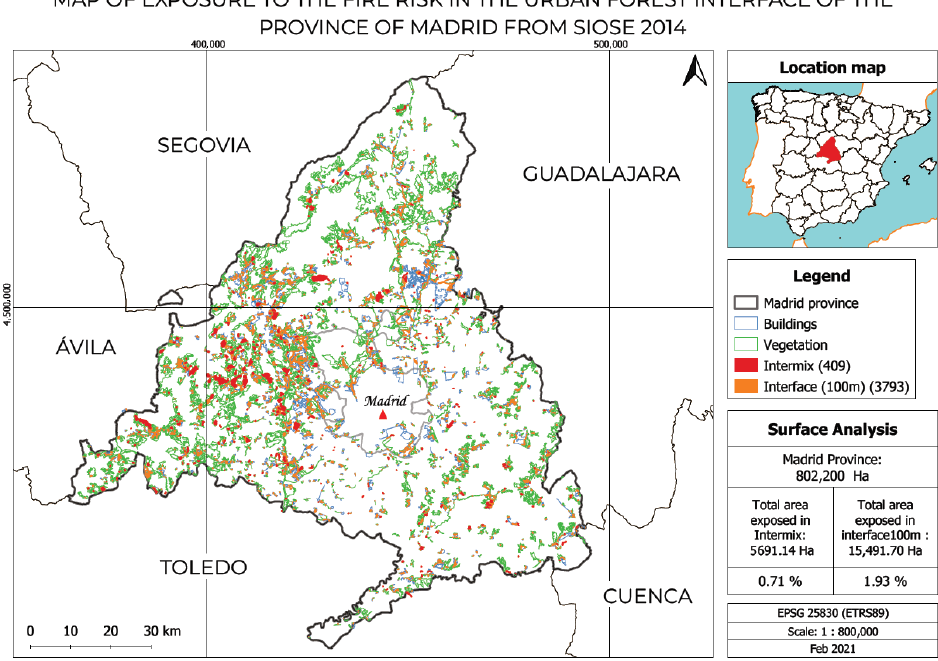
Figure 4. Exposure to wildfire risk in WUI of Madrid.